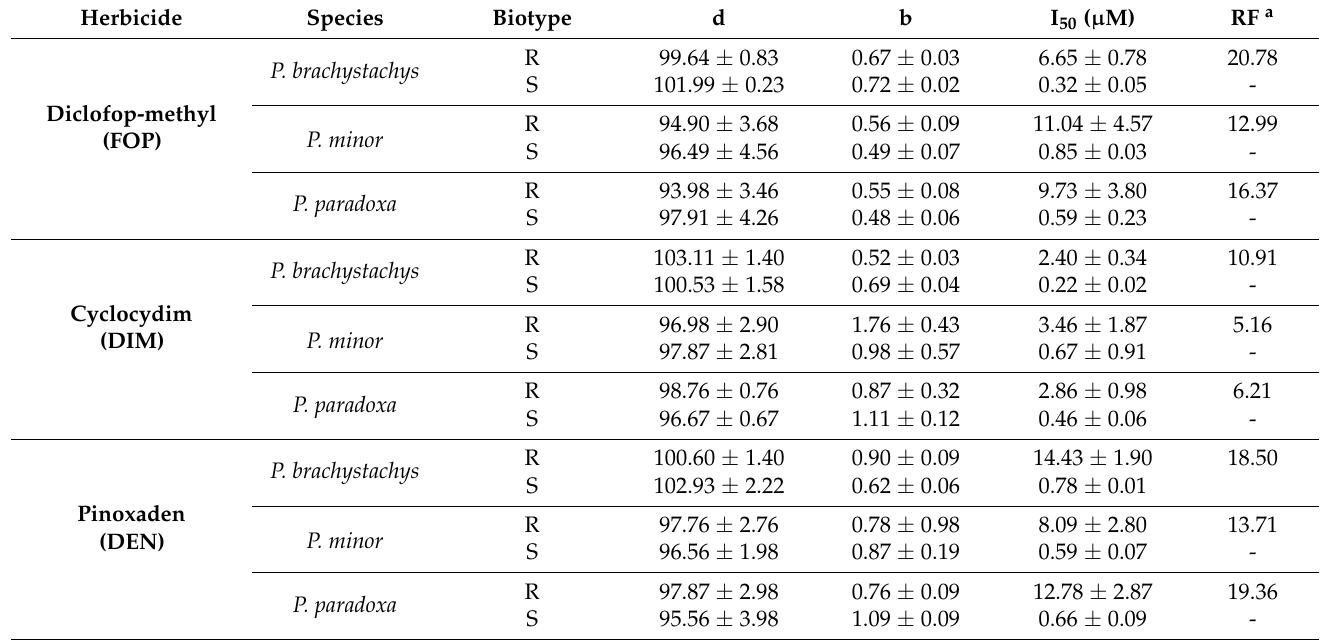
cyclohexanediones; and DEN, phenylpyrazolines.